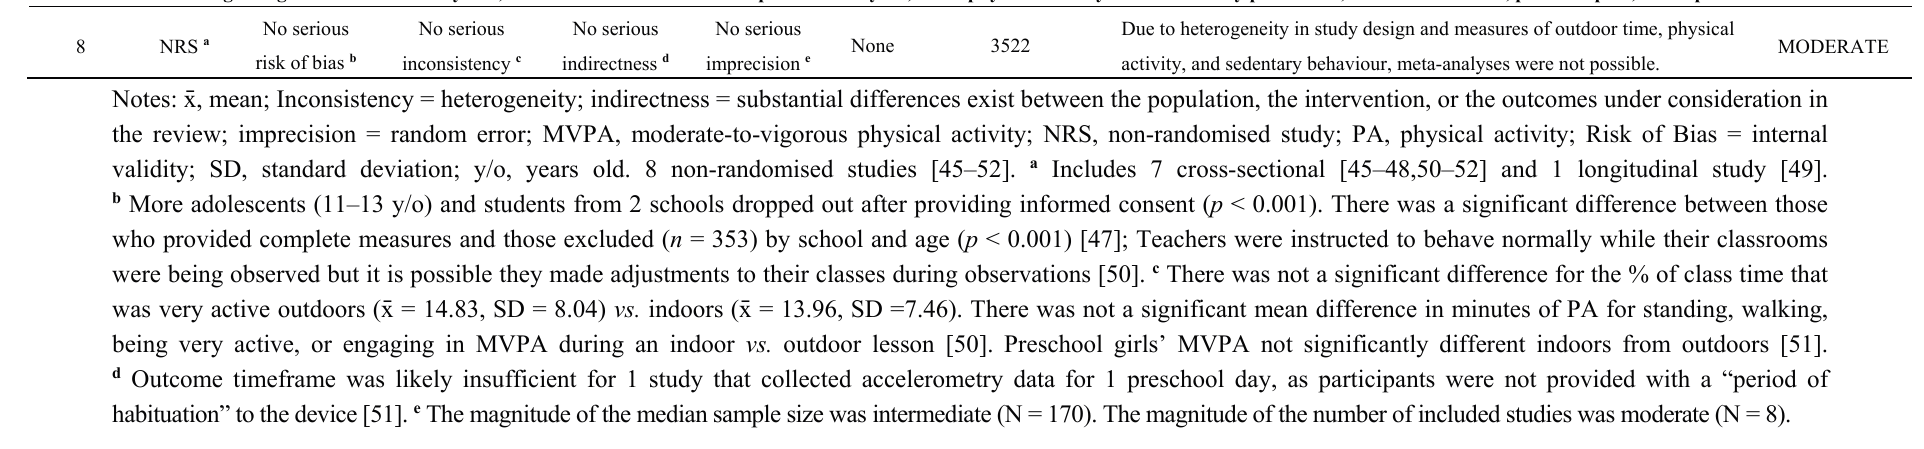
Table 3. Associations between outdoor time and habitual sedentary